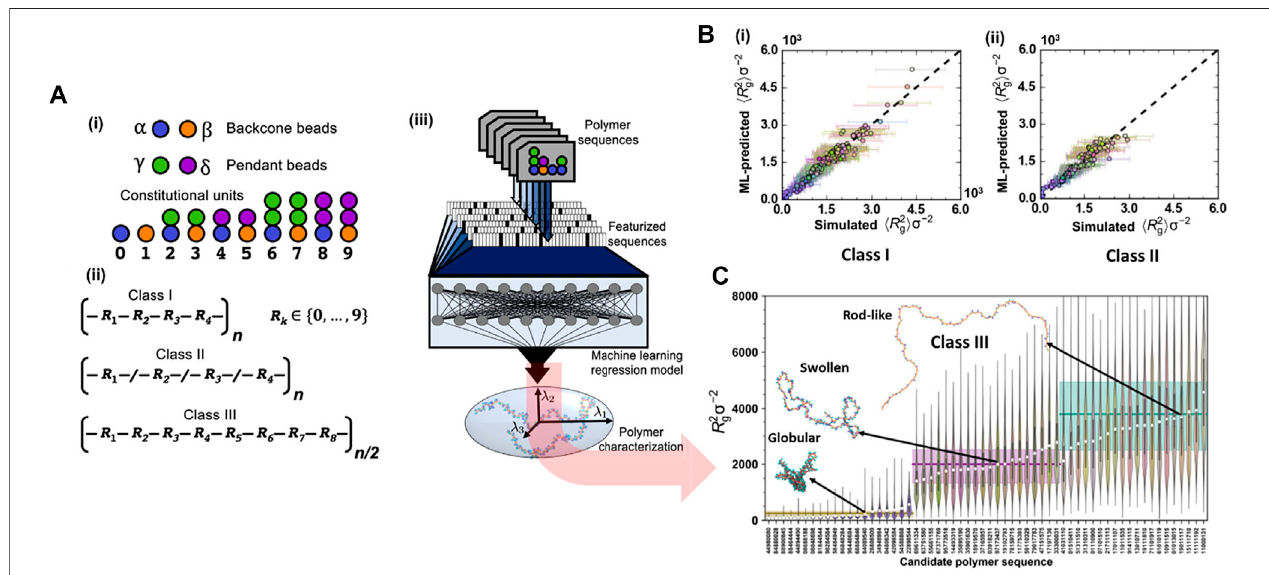
FIGURE8| Inverse design fortarget polymeric con fi gurations. (A) CGMD/ML couplingisused fortheprediction ofcopolymeric radius ofgyration (R g value): (i) CG bead types used in MD simulation include backbone types ( α or β ) and pendant types ( γ or δ ). The allowable combinations of backbone and pendant beads yield 10 uniqueconstitutionalunits(CUs); (ii) threeclassesofpolymersarestudiedincludingclassI,II,andIIIrepresentedbydifferentsequencesofCUs:classIrepresentsregular copolymers with a repeat pattern of four CUs, class II includes random polymers constructed from four CUs and class III constructed with a repeat pattern of eight CUs; (iii) Scheme ofML model for predicting polymer properties or R g values. The entire polymer sequence or arepeat unit ofitisfeaturized and used as inputto aDNN model,whichestablishesthestructure-propertyrelationshipofthepolymer. (B) PerformanceofMLmodelforpredictionofthemeansquareradiusofgyration, 〈 Rg 2 〉 ,for class Iand classIIpolymers: (i) theprediction forclass IisvalidatedbyCGMD modeling withthe r 2 of0.953,and the mean absoluteerror (MAE) of111.32; (ii) themodel trained on class I is applied for class II prediction with the r 2 of 0.895, and the MAE of 130.34. (C) Targeted sequence design of class III polymers using the Tree- structured Parzen Estimator (TPE) algorithm. The result presents three sets of recognizable predictions, with the globular polymers ( fi rst 20 polymers from the left) separated from the swollen targets (next 20 targets), which are easily distinguishable from the rod-like structures (last 20 targets) as well as fi t with the statistical distribution of R g2 obtained from CGMD validations (in the form a violin plot). Figure was reproduced from Ref. (Webb et al., 2020) with